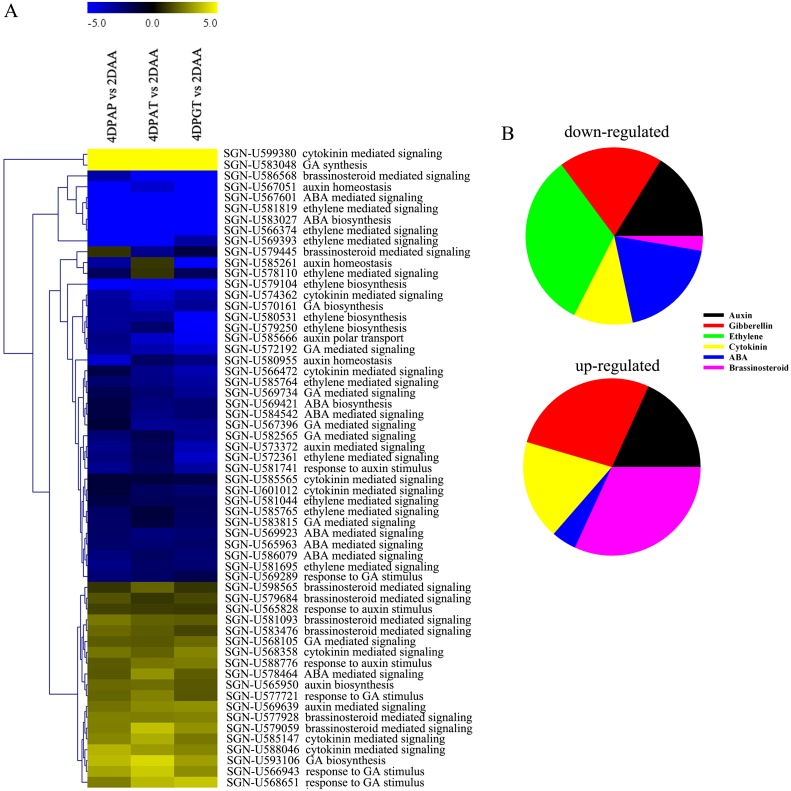
DEGs associated with hormone biosynthesis and signaling.(A) Cluster analysis of DEGs associated with hormone biosynthesis and signaling. (B) Pie charts show the percentages of up- and down-regulated DEGs involved in hormone biosynthesis and signaling during fruit set.